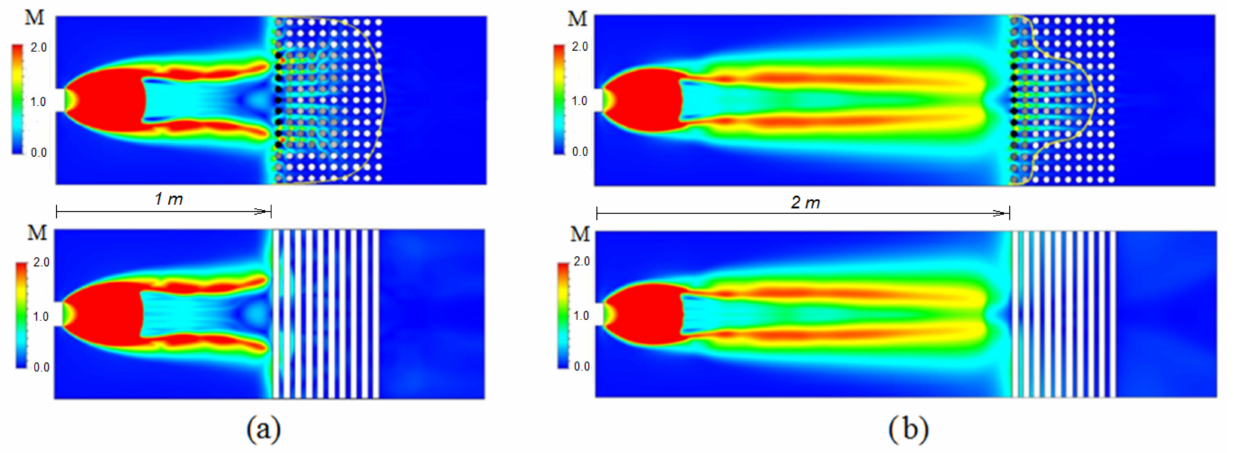
Figure 9. Blowing of the tube package by an air jet with a pressure of P 0 = 2.35 MPa. ( a ) Case 10; and ( b ) case 14. Upper—XOY plane, lower—XOZ plane.